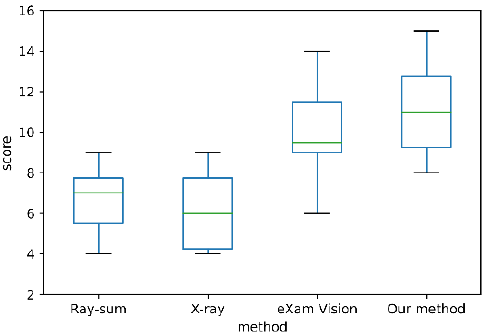
Figure 8. Boxplot of contrast scores for panoramic images.